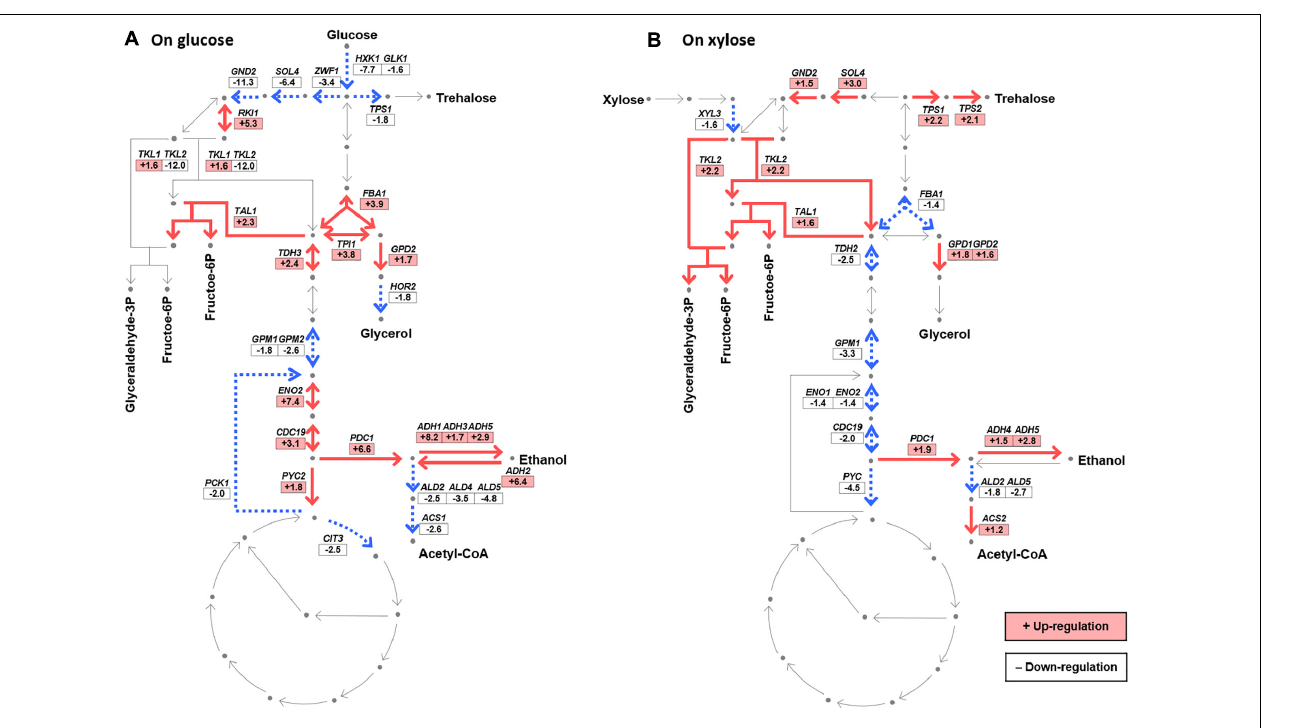
FIGURE 4 | Transcriptional changes in the central metabolic pathways induced by (cid:49) gcr2 during glucose (A) or xylose (B) metabolism. The fold change in expression in (cid:49) gcr2 mutant relative to that in the wild-type strain is presented ( p < 0.05). Glyceraldehyde-3P, glyceraldehyde-3-phosphate; fructose-6P, fructose-6-phosphate; acetyl-CoA, acetyl coenzyme A. RNA samples were extracted from exponentially growing SR7 and SR7 (cid:49) gcr2 strains on glucose and